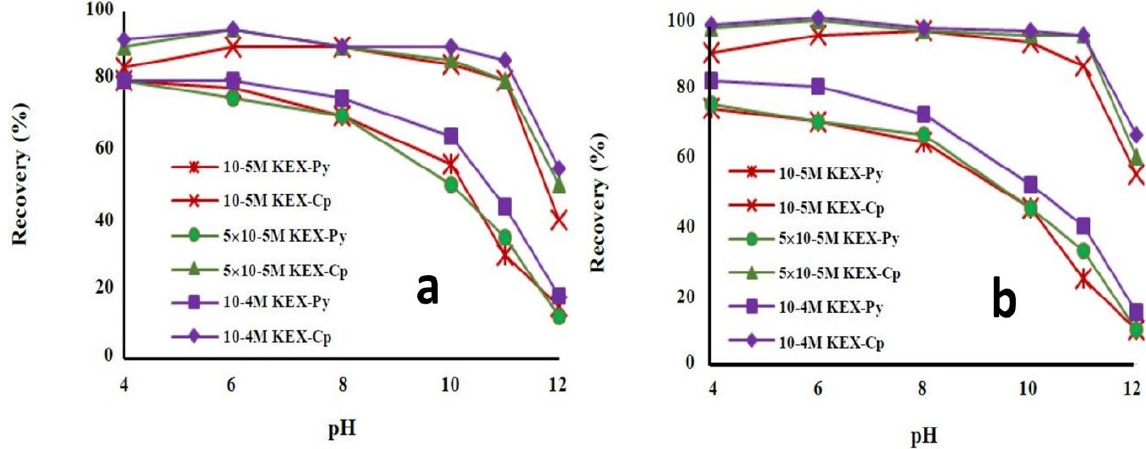
Figure 31. Chalcopyrite (Cp) and pyrite (Py) recoveries as a function of the pH at different concentrations of KEX ( a ) before and ( b ) after ultrasonic treatment [163].